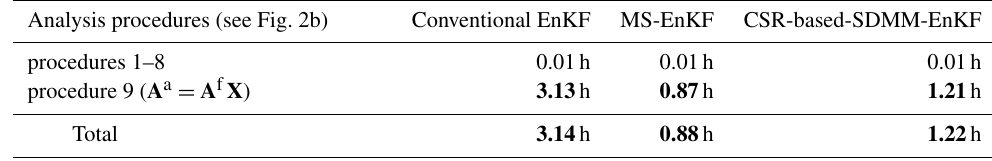
Table 3. Computational time for the analysis step of conventional EnKF, MS-EnKF, and CSR-based-SDMM-EnKF. Analysis procedures (see Fig.